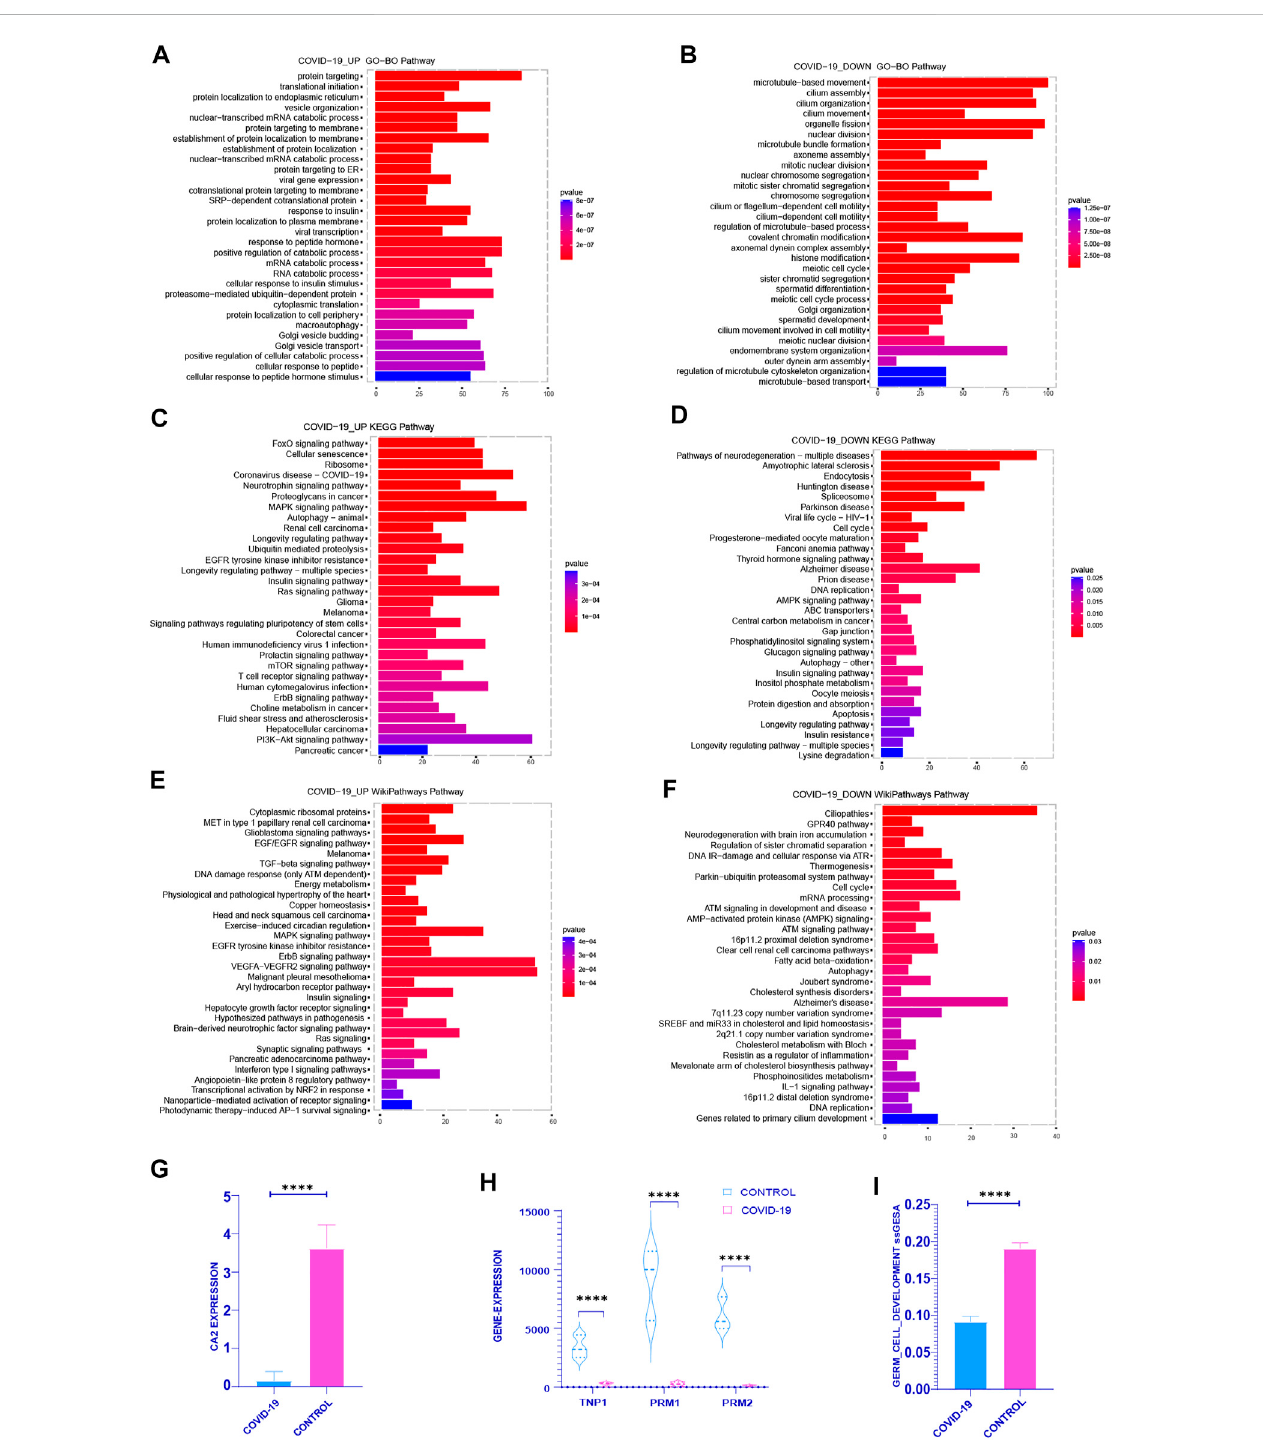
FIGURE 1 Functional enrichment analysis was performed on the differential genes between the COVID-19 group and the control group (including the increased genesetandthedecreasedgeneset). (A,C,E) genesetswereenrichedinGO,KEGG,WIKIPATHWAYS,respectively,andthetop30enrichmentpathwayswere selected according to Adj-p-Value from small to large. (B,D,F) decreased gene sets were enriched in GO, KEGG, WIKIPATHWAYS, respectively, and the top 30 enrichment pathways were selected according to Adj-p-Value from small to large. (G) The expression of several typical sperm Markers: TNP1, PRM1 and PRM2 decreased signi fi cantly in COVID-19 group ( p < .001). (H) The expression of classical Marker: CA2 decreased after COVID-19 infection ( p < .001). (I) The ssGSEA score of Germ Cell Development pathway decreased in COVID-19 group ( p <